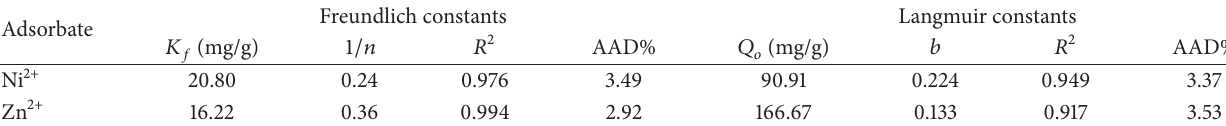
Figure 3: SEM photograph of wasted black tea at 1000x magnification (a) and FTIR spectra of the wasted black tea (b). Table 3: The parameters of Freundlich and Langmuir adsorption equations.